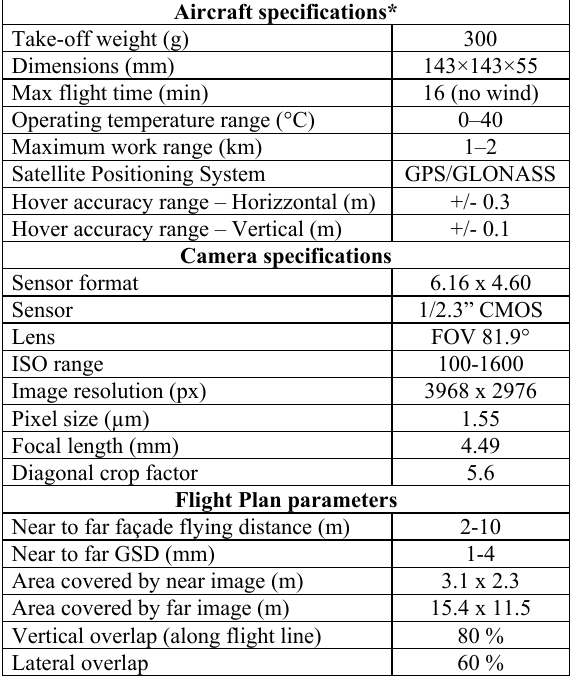
Figure 3. DJI Spark during one of the flight missions. Table 1. DJI Spark specifications (*from www.dji.com) and flight plan